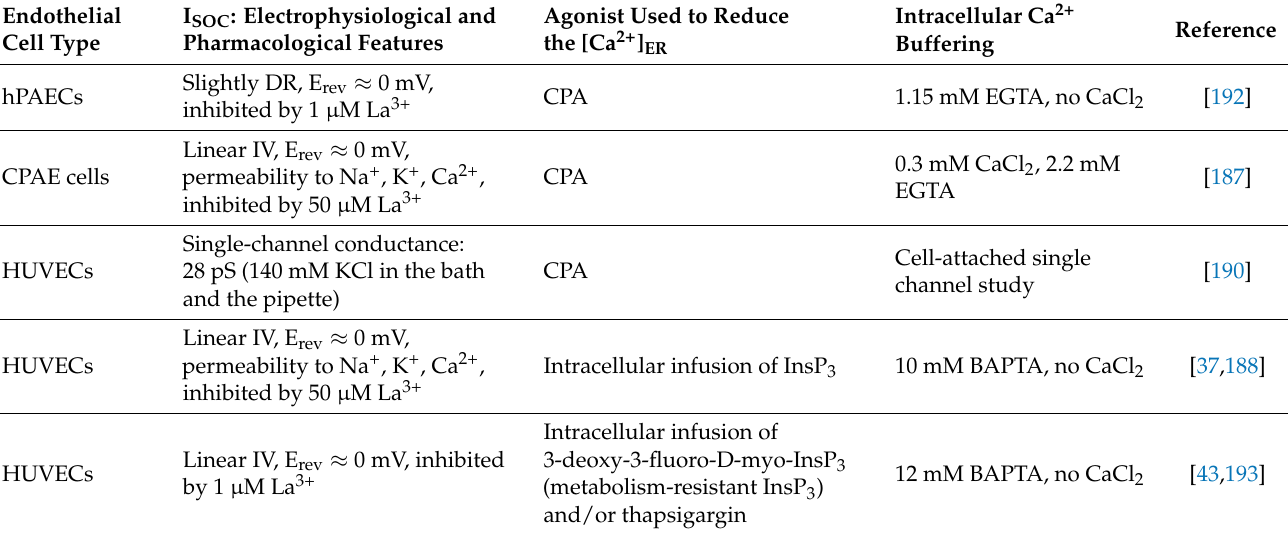
Table 5. Electrophysiological features of the endothelial I SOC